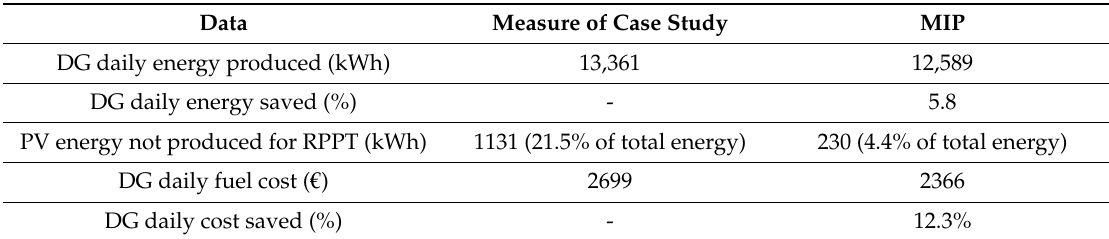
Table 10. Comparison between case study and MIP model’s